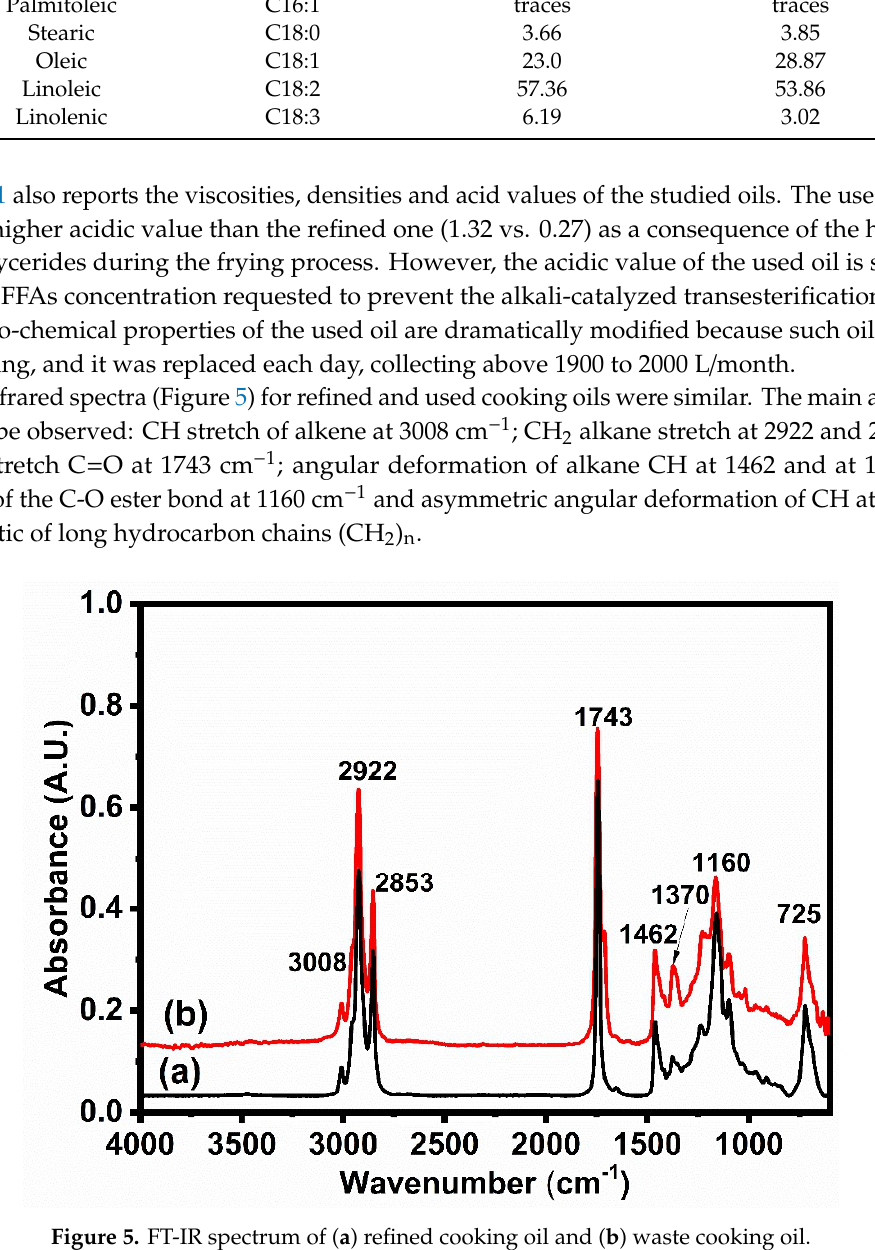
Figure 5. FT-IR spectrum of ( a ) refined cooking oil and ( b ) waste cooking